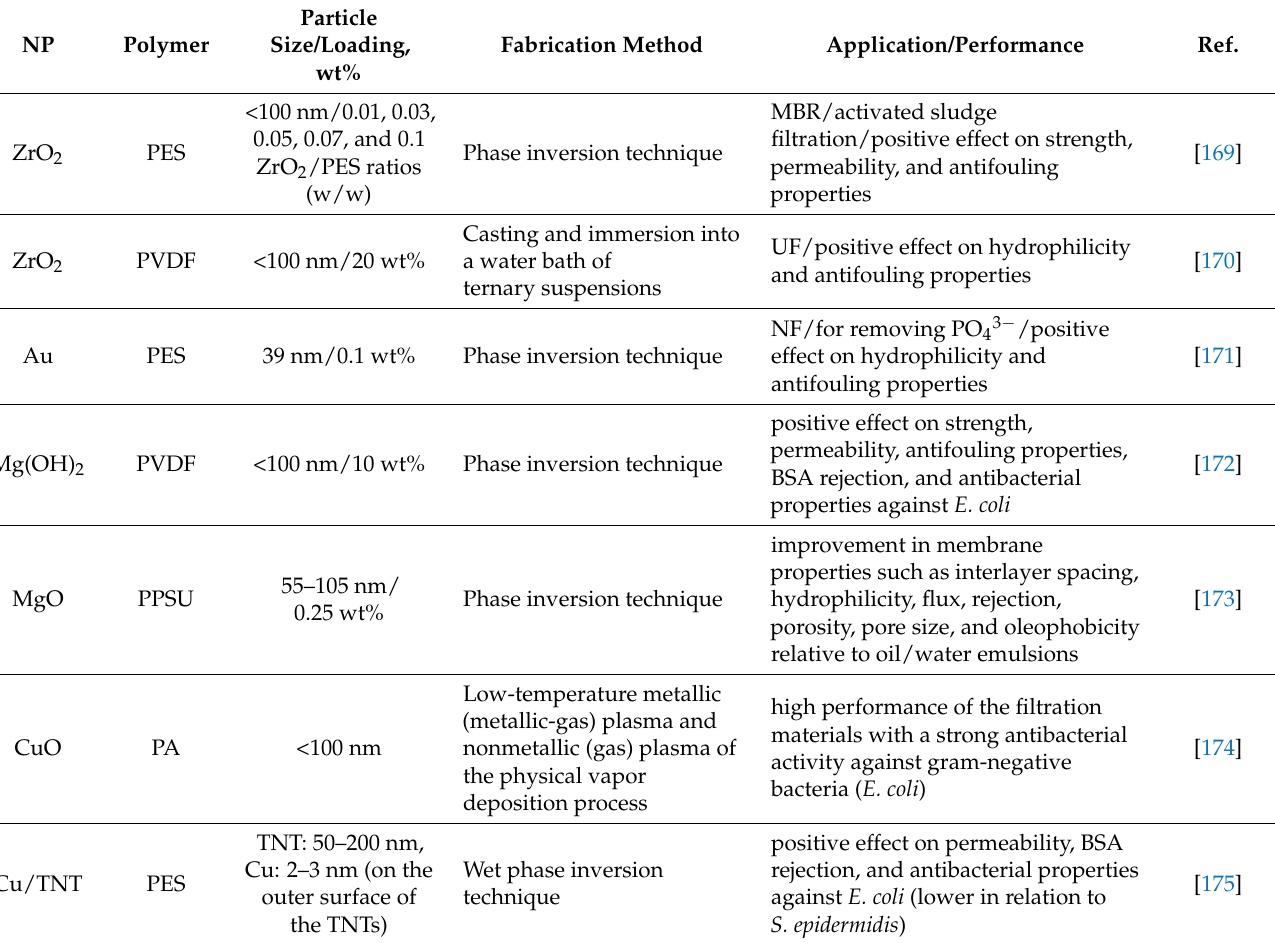
Table 7. Select applications of various types of selected metals in